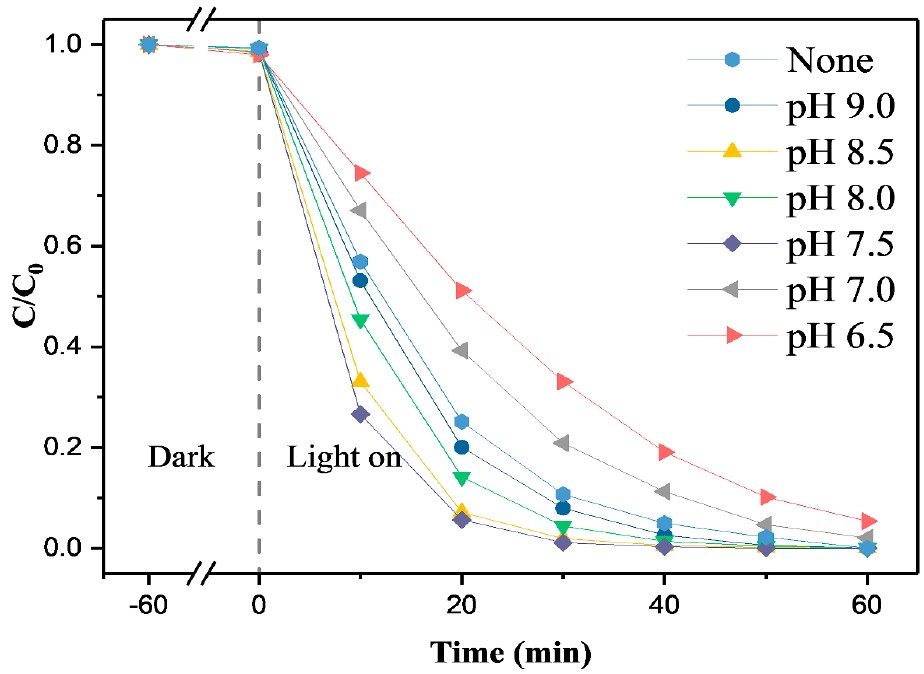
Figure 3. Effect of 0.6-SiO 2 -M-Y/TiO 2 composite photocatalyst on the degradation of methyl or-